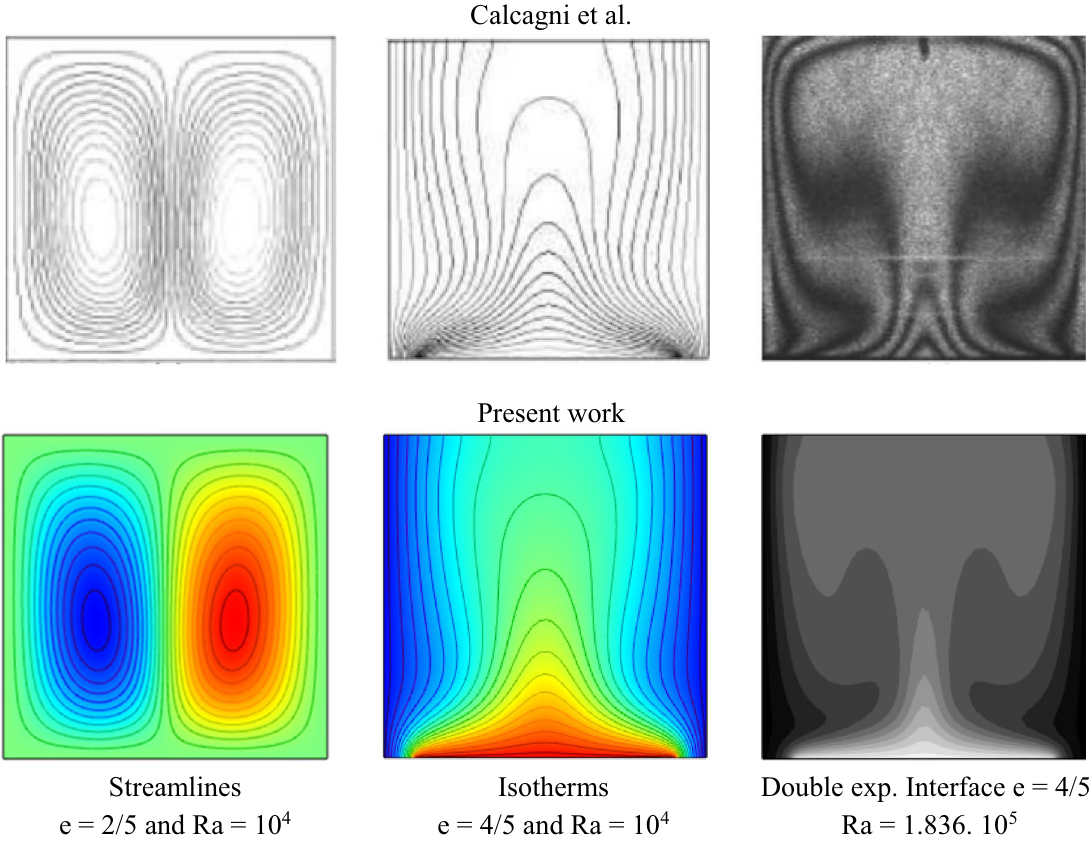
Figure 3. Compared with experimental and numerical results of Calcagni et al. 57 The isotherms line for all Ra* at Da = 10 –2 is close to vertical lines. Furthermore, the isotherms at a high amount of Da are parallel to the vertical axis, indicating that conduction is the primary mechanism of heat transport at high Darcy number values. In contrast, by decreasing Da, the heat transfer convection mechanism becomes more important. When Ra* is increased from 10 2 to 10 4 at Da = 10 –4 , the isotherms line changes because the fluid near the wave is heated and flows in the curve form; increasing Ra* decreases the solid wavy wall temperature, indicating improvement in the heat transfer rate from the fluid. Increasing Ra* indicates that the convective flow intensifies with intense isothermal distortions within the fluid. At Da = 10 –2 , when Ra* increases from 10 2 to 10 4 , the stream function increases from ψ max = 0.0023 to ψ max = 0.23 for a hybrid nanofluid. For Da = 10 –4 , when Ra* increases from 10 2 to 10 4 , the stream function increases from ψ max = 0. 23 to ψ max = 8.7 for hybrid nanofluid. The Darcy number was observed to impact the stream function significantly. The flow strength and buoyancy force are at a very low Darcy number (Da = 10–4). The relationship between the local Nusselt number and Ra* on the wavy surface is shown in Figs. 7 and 8 at ϕ = 0.01, Da = 10 –4 , (A = 0.1, 0.2, 0.3), and (N = 1, 5). The heat transfer increases with increasing Ra*, which improves with the amplitude and the number of waves. It is apparent that when the Ra* changes from 10 2 to 10 4 , the maximum production for Ra = 10 4 .